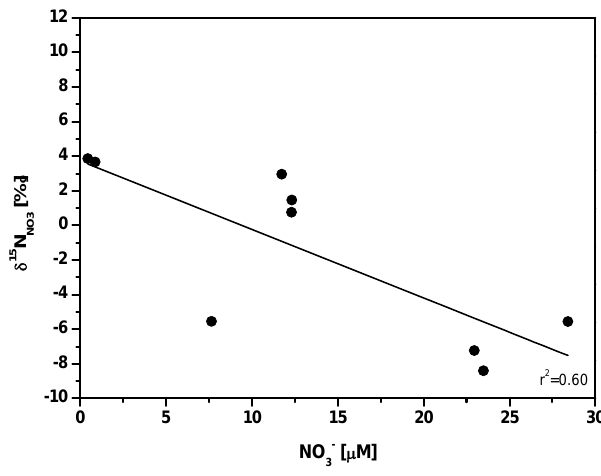
Fig. 6. Relation between δ 15 N NO together with a regression line indicating the denitrification that oc- curred in October